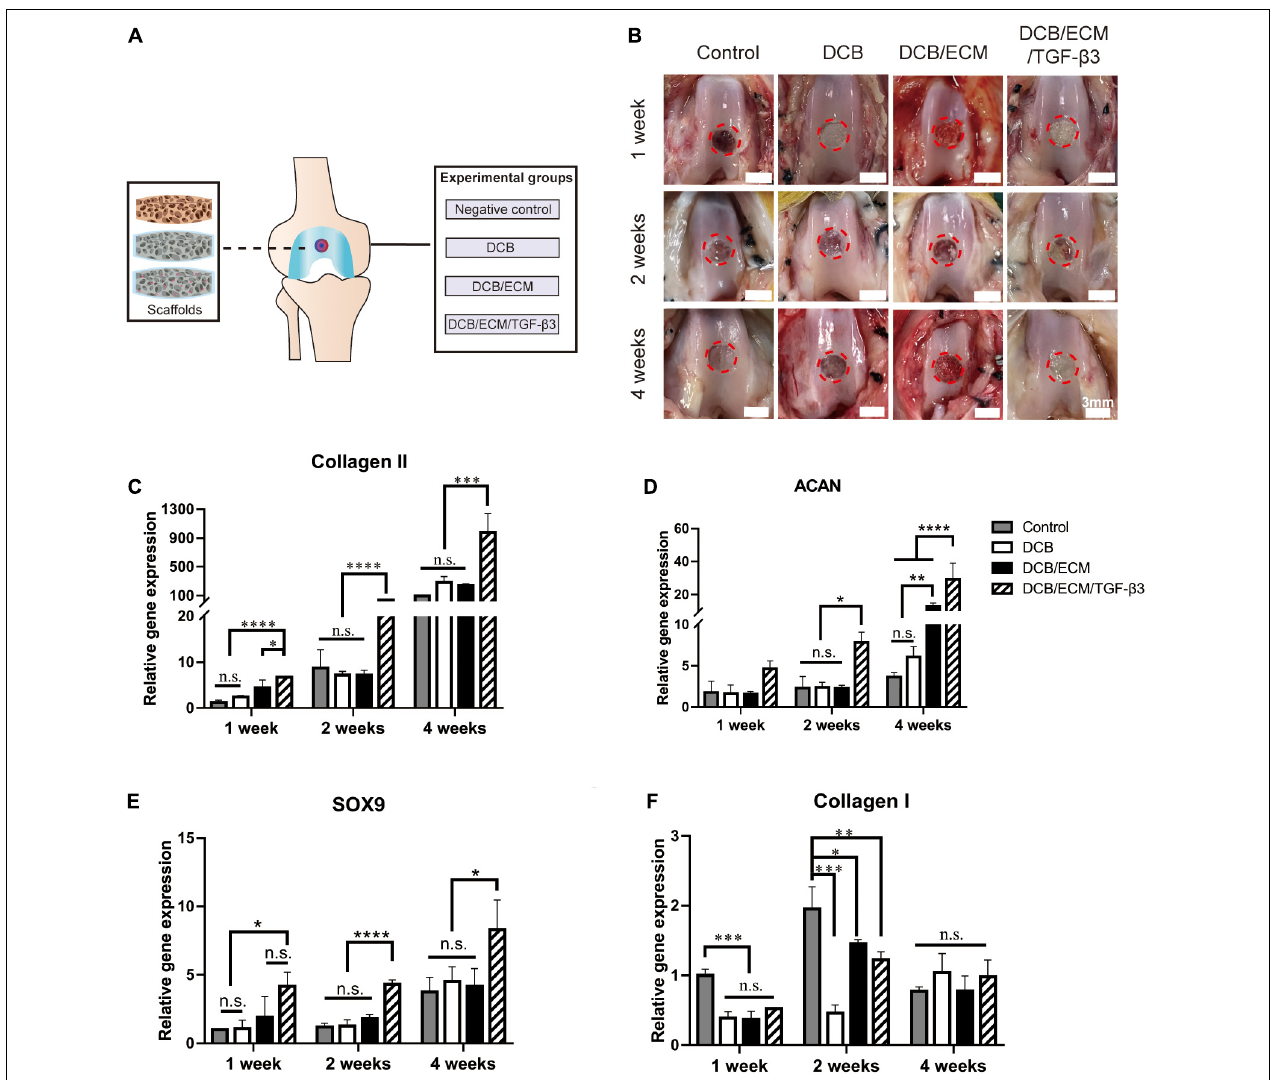
FIGURE 3 | In vivo chondrogenic differentiation assay. (A) Scaffold implantation and experimental grouping schema. (B) Representative macroscopy of repaired tissues at 1, 2, and 4 weeks postsurgery. The red circles indicate the repaired areas. (C–F) Quantitative polymerase chain reaction (qPCR) analysis for collagen II, aggrecan (ACAN), transcription factor SOX9 and collagen I. The qPCR results were repeated three times independently. Data are means ± SDs (* p < 0.05, ** p < 0.01, *** p < 0.005, **** p < 0.001, n.s. represents no significant